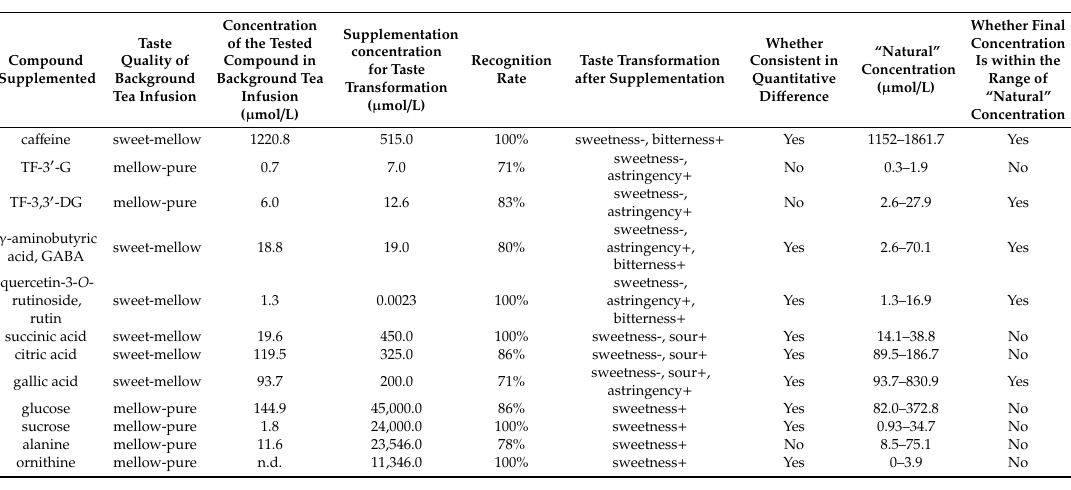
Table 4. Influence of 12 individual candidate compounds on the taste profile of sweet-mellow or mellow-pure background black tea infusions, revealed by supplementation experiments and human sensory evaluation. Supplementation concentration for taste transformation indicates the lowest supplementation concentration required for a detectable taste transformation by more than 70% of the assessors, which is calculated as the supplementation amount / volume of tea infusion. “Natural” concentration indicated the concentration range detected in the congou black tea infusions in this